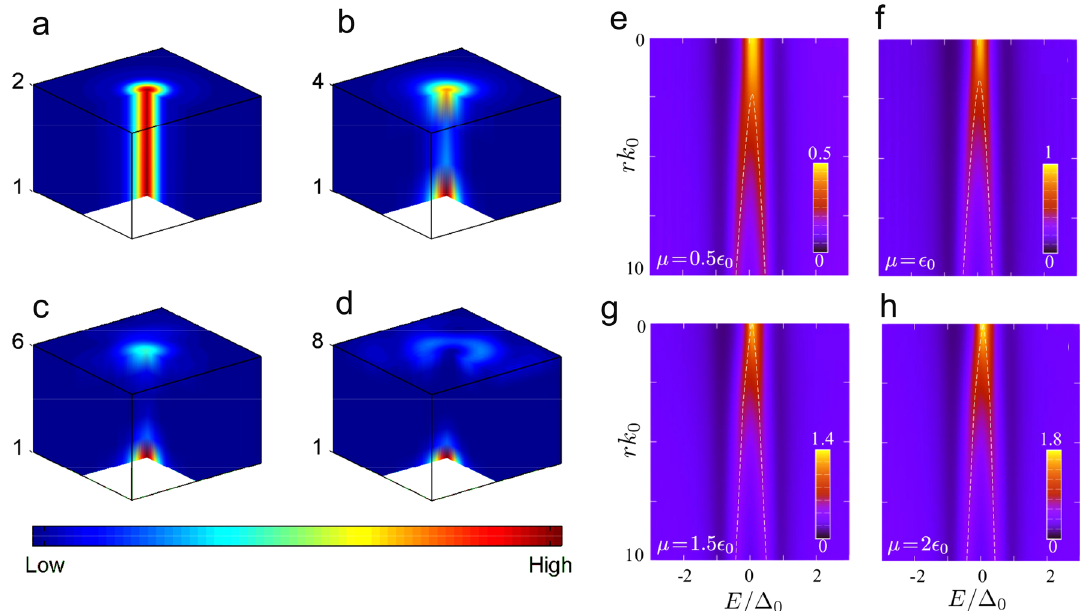
Fig. 4 Theoretical calculated Spatial distribution of MZM. a – d The wavefunction pro fi le of MZM. a n = 2, b n = 4, c n = 6, and d n = 8. In each panel, a corner is cutoff to reveal the interior of the TI. The size of the sample is L × L , where L = 15 ξ 0 and ξ 0 is the coherence length of the superconducting substrate. e – h The local densitity of states as a function of vortex radius r and STS measurement energy E . Dotted curves are guides for the eye. 2 ε 0 is the size of the band gap of the TI fi lm, μ is the distance between the Fermi level and the dirac point of the TI. Δ 0 is the ¼ ν = ε (cid:5) 2 nm, where v ’ s surface state. a – d reprinted by permission proximity induced superconducting gap. k (cid:4) 1 F 0 F is the Fermi velocity of TI 0 from Macmillan Publishers Ltd: Scienti fi c Reports, ref. 35, copyright 2014. e – h reprinted with permission from ref. 42, copyright 2015 by